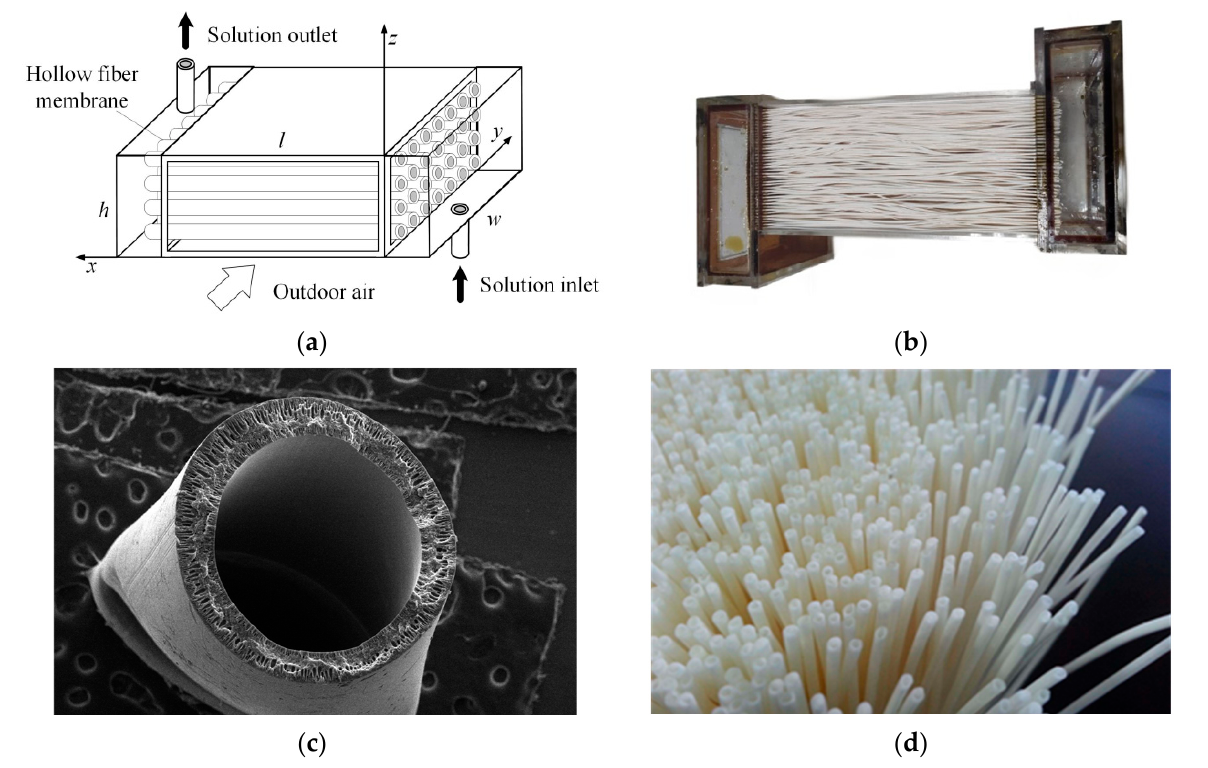
Figure 3. Hollow fiber membrane module: ( a ) schematic diagram; ( b ) structure; ( c ) microstructures; ( d ) physical objects. Table 1. Geometry structures and membrane properties of the hollow membrane module.